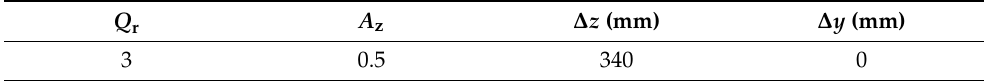
Table 3. Some typical parameters of the OAU and the passive balise (Part